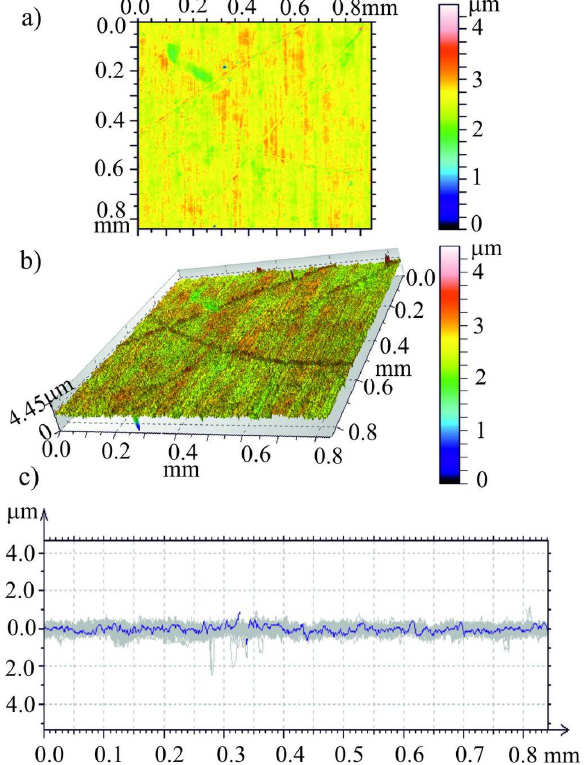
Fig. 5. Fragment of the plate’s smooth surface 0.65 mm thick: a) topography of a fragment of the melts, b) 3D topography, c) roughness profile.